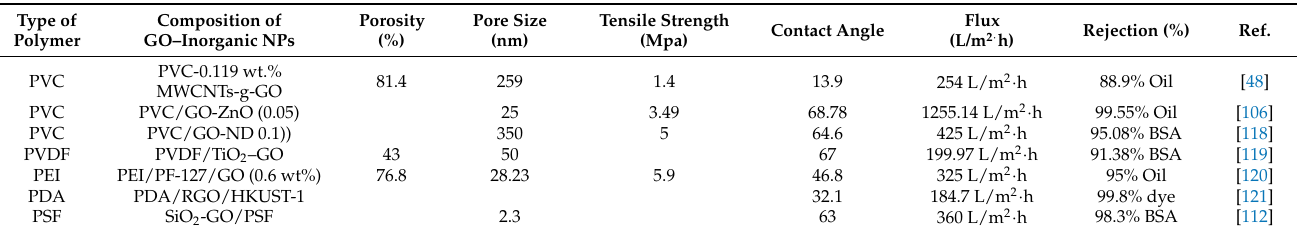
Table 4. MMMs made of different polymers and combined GO–inorganic